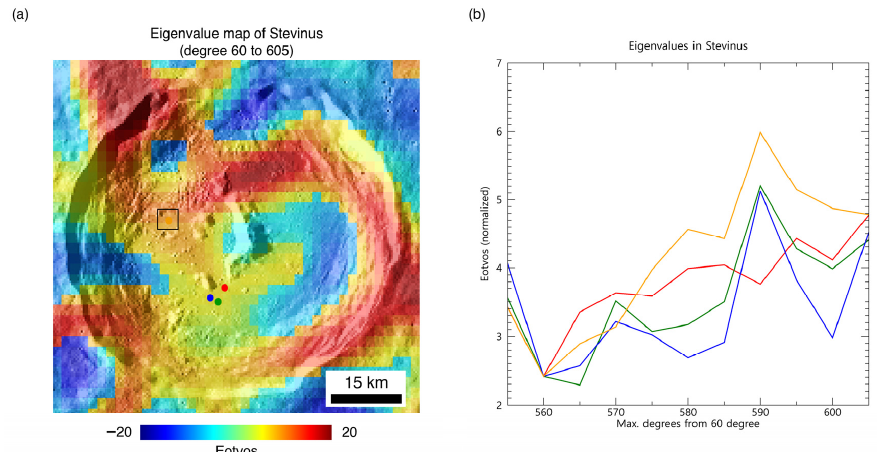
Figure 7. Eigenvalues map and eigenvalue variation of Stevinus pit region. ( a ) All four points indicating a mass deficit are located in the positive feature. The yellow point had low visibility, so a black box was additionally displayed. ( b ) Green and blue have weak oscillation, but an increasing trend appears in all four data points. The plot is normalized at 560 degrees for trend change visibility. Tycho is located on the near side of the Moon and has a diameter of 80 km. Unlike the other three regions (Copernicus, King, and Stevinus), in the crater, all pits are distributed separately except for one region where five clusters are formed. As a result of the analysis, only 1 of the 24 pits showed a positive trend (Figure 8a,b).